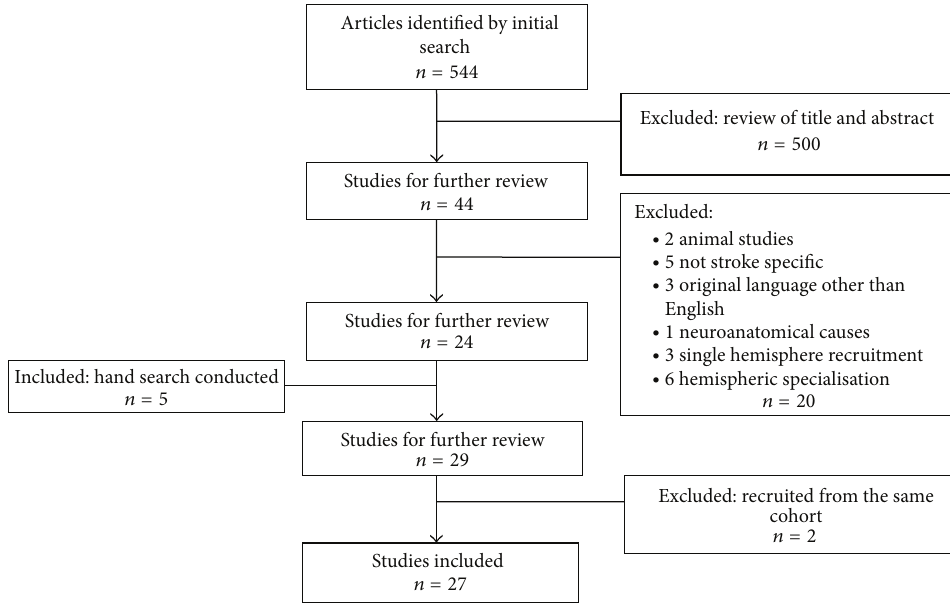
Figure 1: Selection of